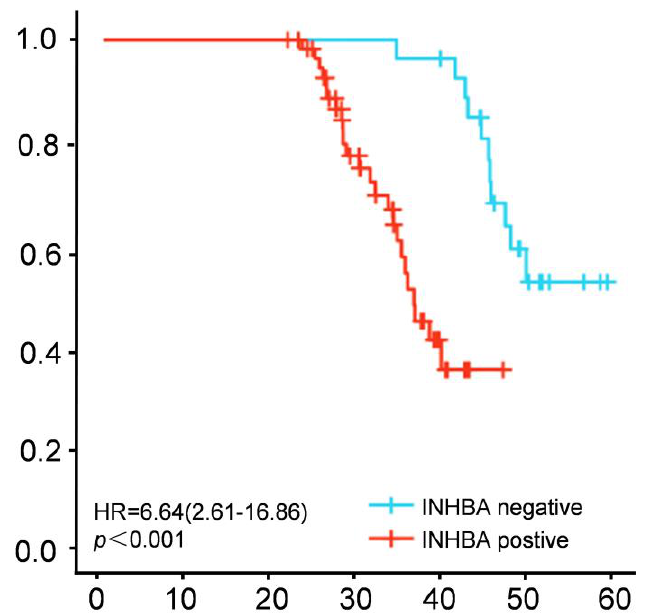
Figure 4. The relationship between the INHBA expression and the clinical prognosis of patients with CC was analyzed through the Kaplan–Meier survival curve.